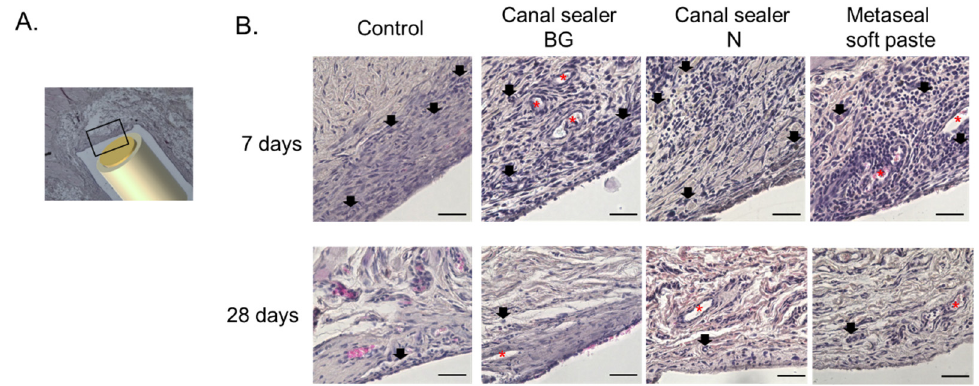
Figure 2. Histological evaluation of the subcutaneous tissue around each root canal sealer. The subcutaneous tissue around the RCO sealer was observed histologically (n = 6 per material). The observation site was the area that was in contact with the RCO sealer ( A ). Representative images of each material 7 and 28 days after subcutaneous implantation are shown ( B ). Black arrows and red asterisks indicate inflammatory cells and vascular structures, respectively. RCO: root canal obturation.